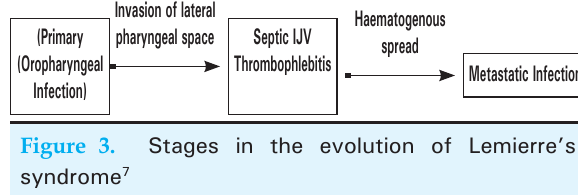
Figure 3. Stages in the evolution of